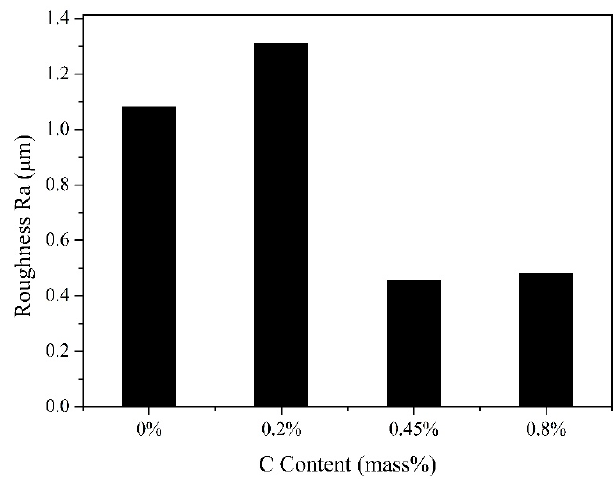
Figure 6. Comparison of tooth flank roughness in materials with different carbon content.